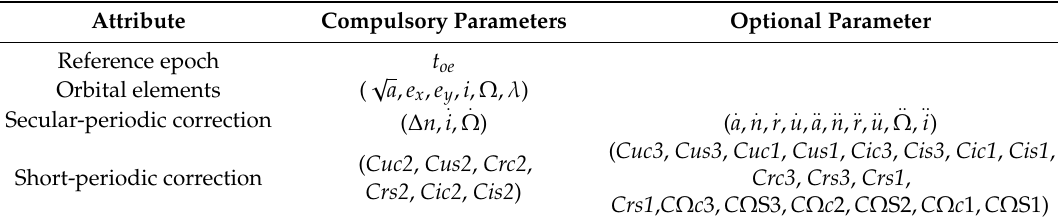
Table 2. Compulsory and optional parameters for broadcast